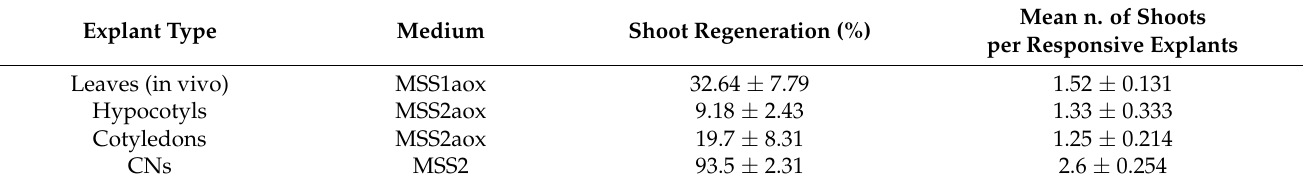
Table 2. Shoot regeneration (%) and mean n. of shoots per responsive explants: maximum score recorded among the experiments related to di ff erent explant types. Data are presented as mean ± SE.